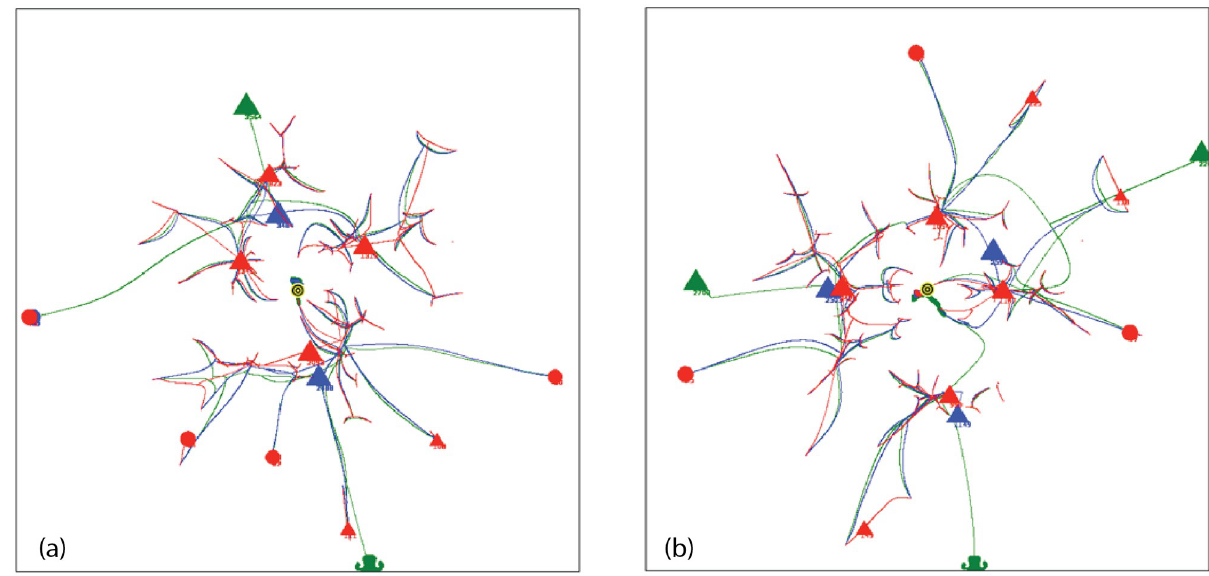
Fig 12. Overlay of simulations with AIB = 30(red), 60(blue), 180(green). a) Seed = 51, Number of final agents = 10(red), 3(blue), 2(green). b) Seed = 71. Number of final agents = 10(red), 3(blue), 3(green).